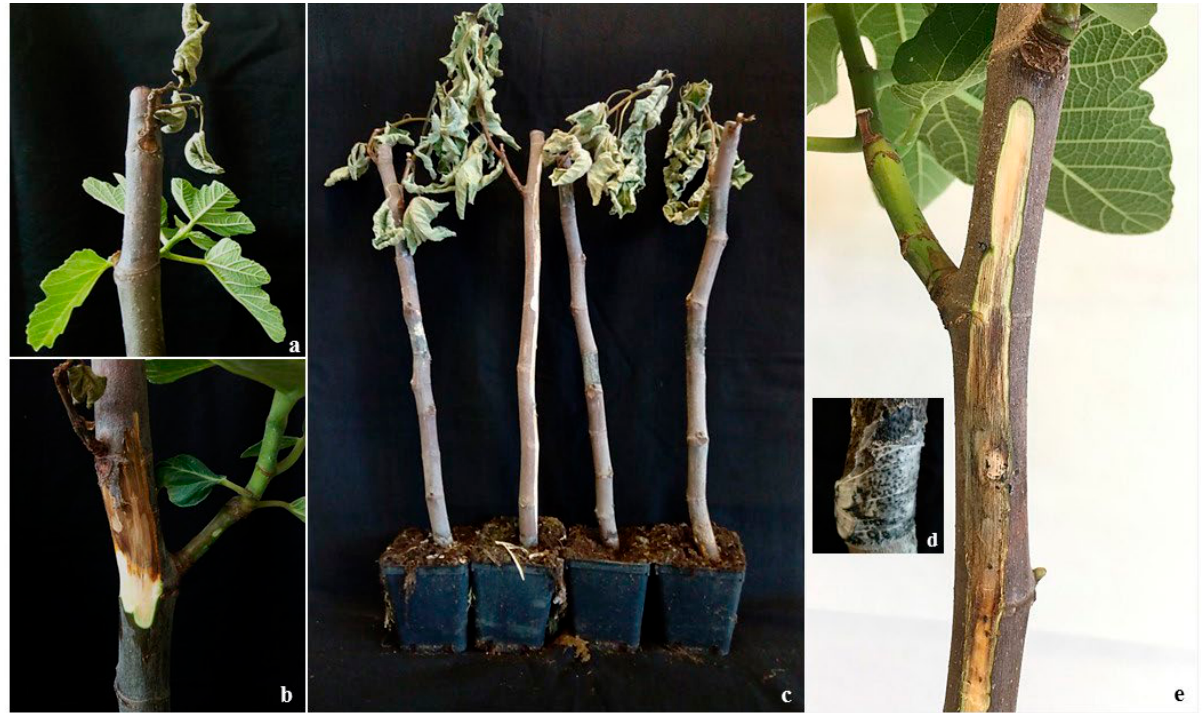
Figure 1. Natural symptoms of disease (a, b) and disease symptoms reproduced from artificial inoculation of fig cuttings (c–e). a, shoot blight; b, internal discolouration; c, shoot blight and apical dieback 26 days after pathogen inoculation; d, dark pycnidia above the inocula- tion point; e, internal lesion and discolouration under the inoculation point after 10 days on artificially inoculated fig